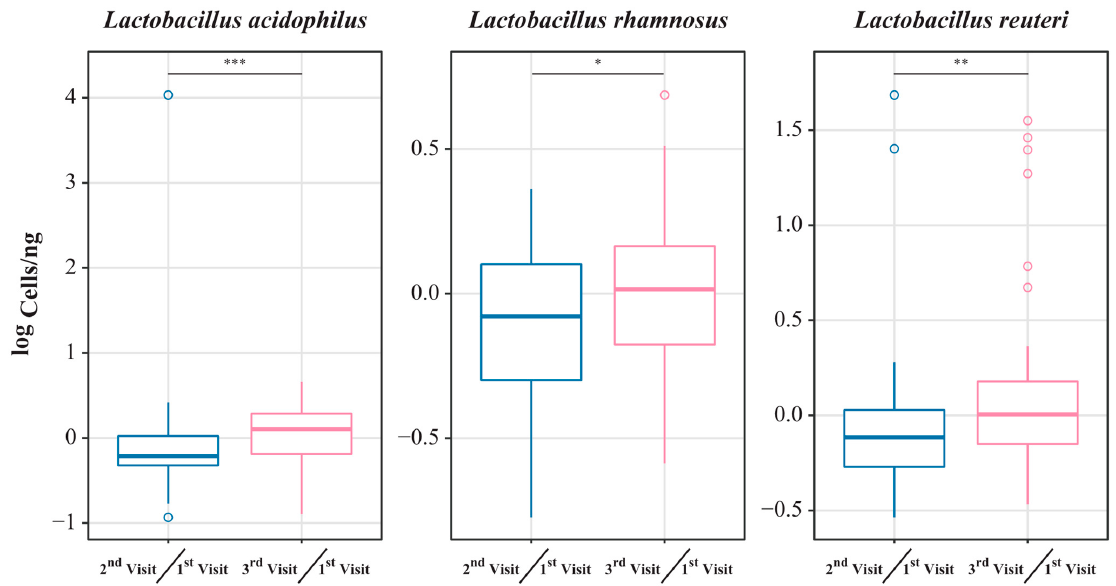
Figure 6. Expression of Lactobacillus spp. present in the oral probiotic in cervicovaginal fl uid sam- ples, as assessed by qRT-PCR. The expression ratio at the second and third visit compared to that of the fi rst visit. qRT-PCR quanti fi cation was expressed as log cells/ng. * p < 0.05, ** p < 0.01, *** p < 0.001 (Wilcoxon signed-rank test). (Wilcoxon signed-rank